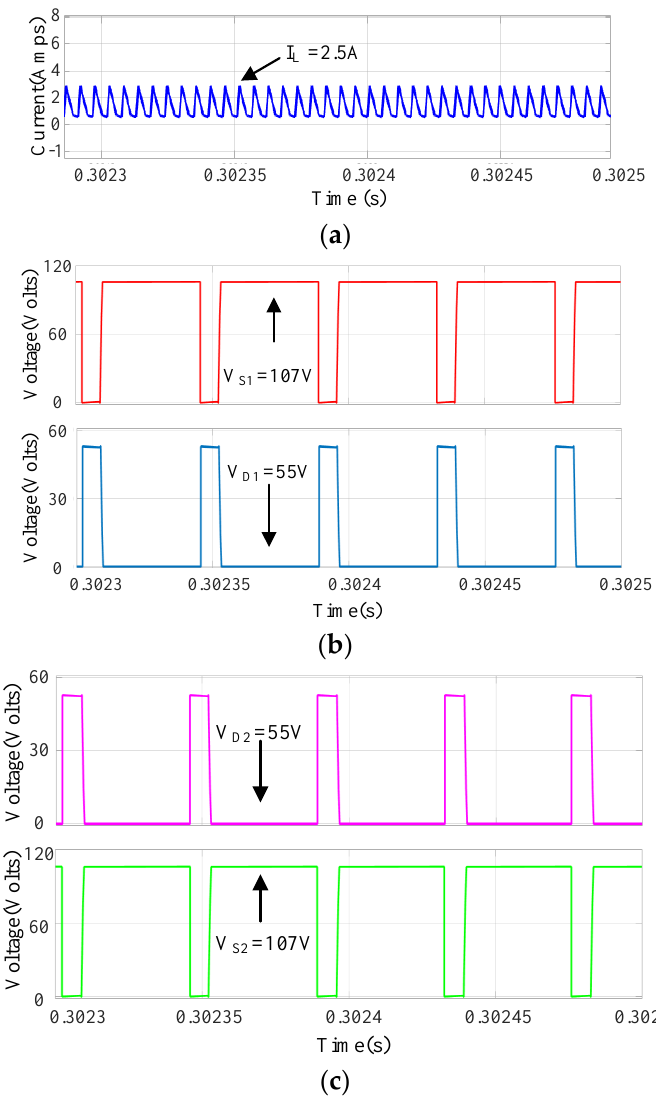
Figure 16. ( a ) Inductor current I L , ( b ) voltage across D 1 and S 1 , and ( c ) voltage across D 2 and S 2. Table 4. Simulations and experimental parameters.